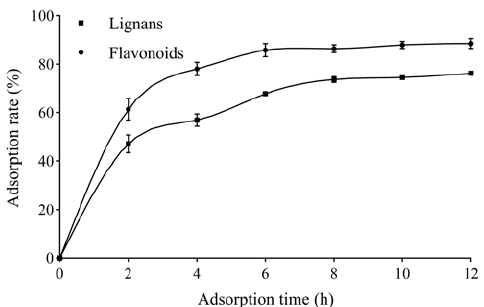
Figure 1. Adsorption kinetics curves for total lignans and flavonoids from V. amurensis extract on AB ‐ 8